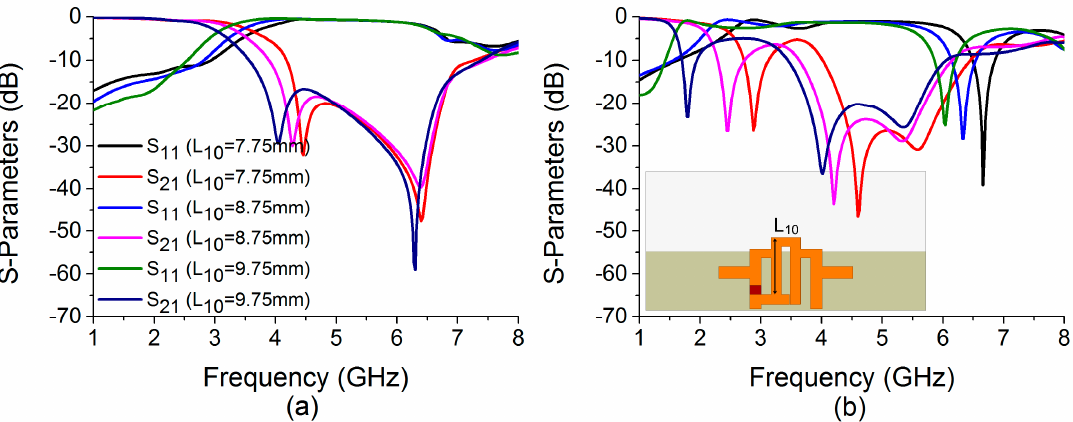
Figure 12. Influence of L 10 on S-parameters in ( a ) mode 1 and ( b ) mode 2.